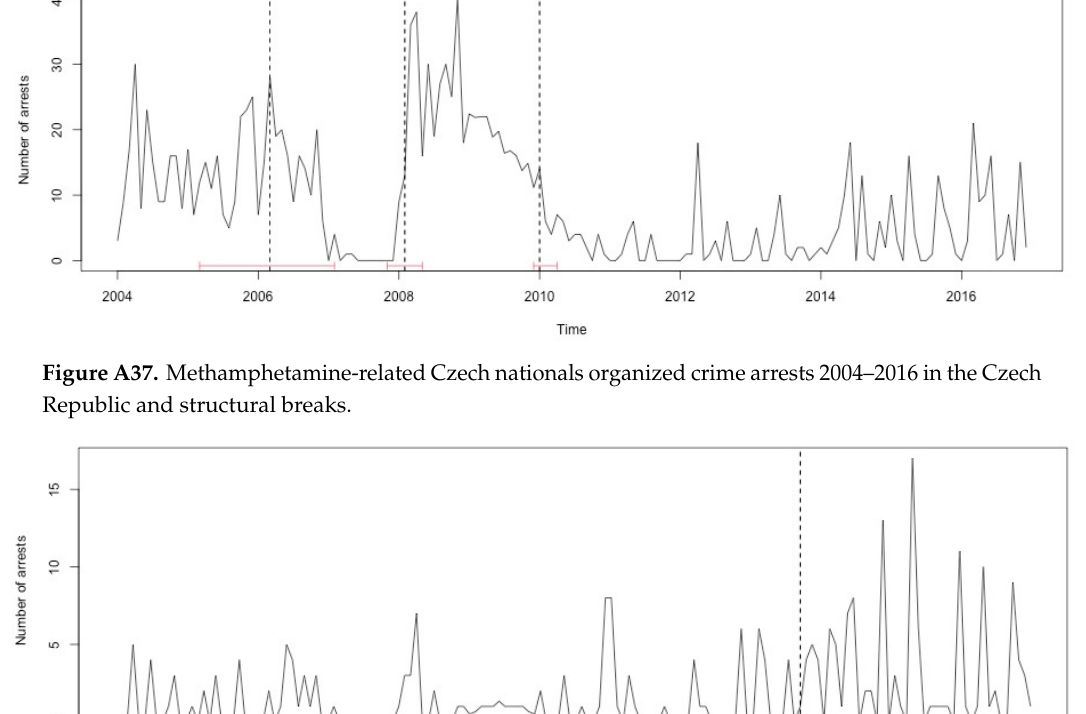
Figure A39. Methamphetamine-related Vietnamese nationals organized crime arrests 2004–2016 in the Czech Republic and structural breaks.